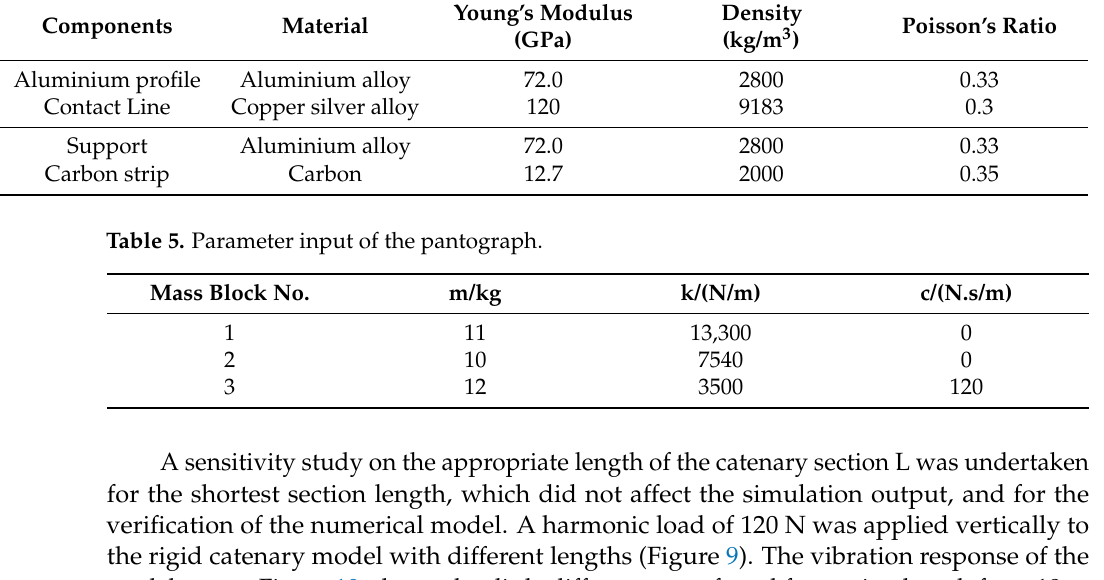
Table 5. Parameter input of the pantograph.